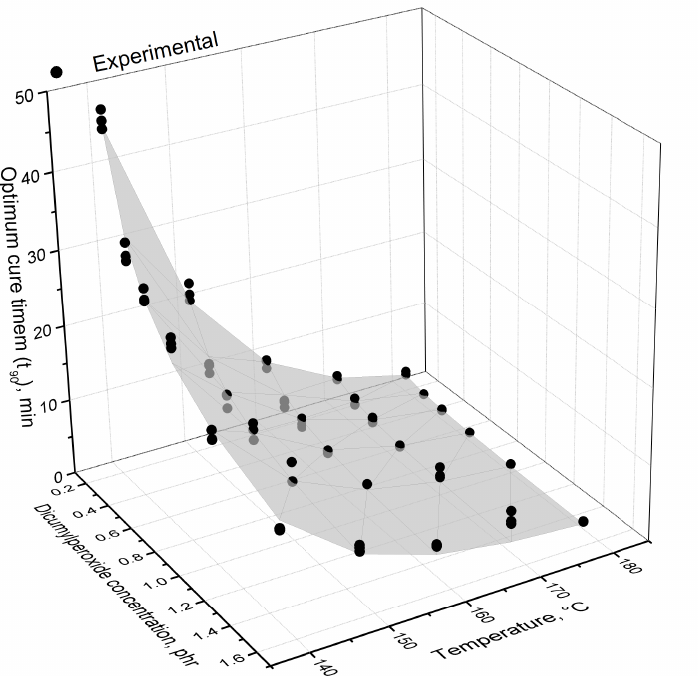
Figure 2. Optimum cure time t 90 as a function of the dicumylperoxide concentration and the temperature. The dots represent the experimental data and the surface indicates the model described at Equation (1), with fitting parameters as follows: A 0 (pre-exponential factor) = 2.02 × 10 − 14 min − 1